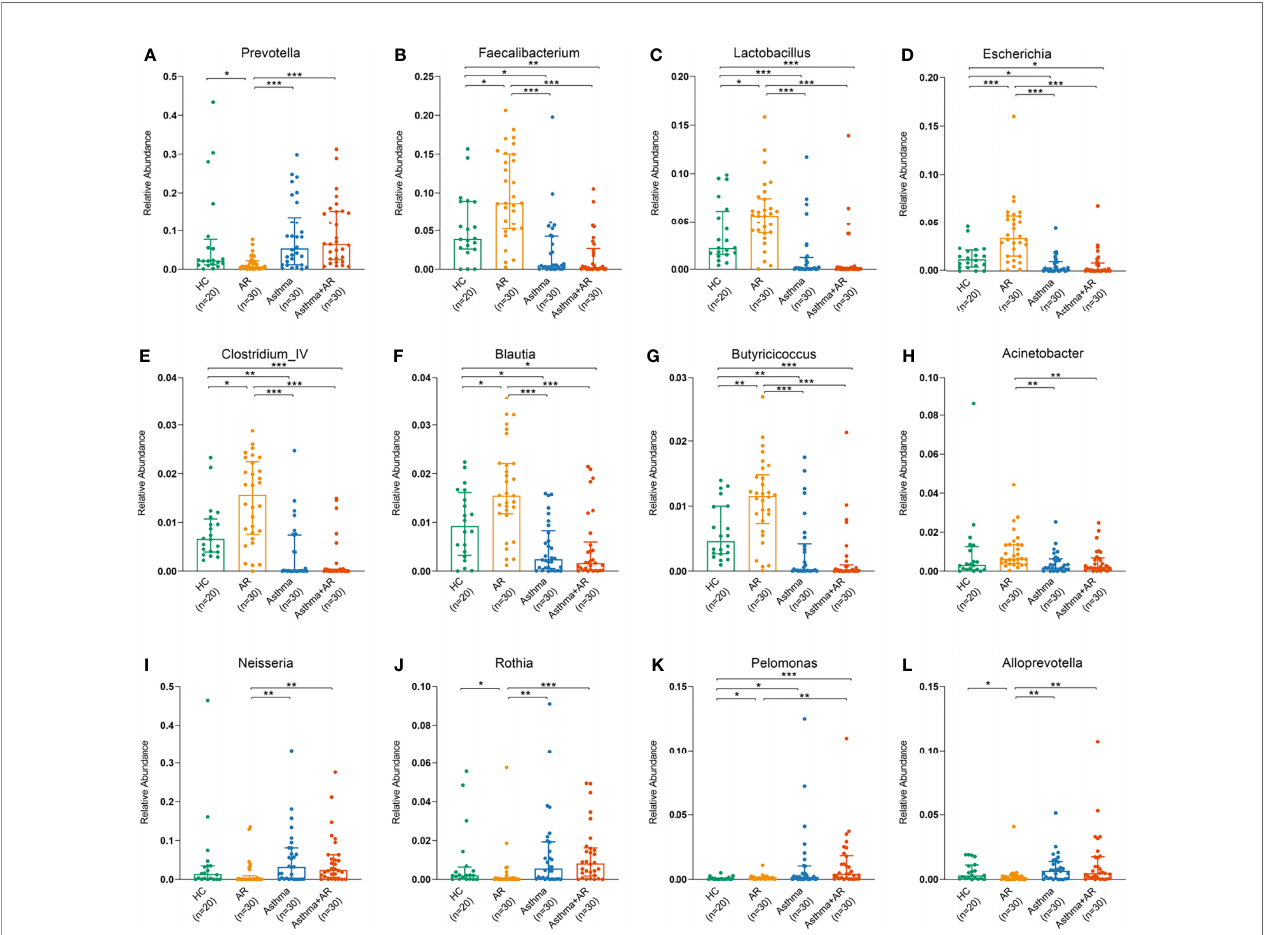
FIGURE 3 | Relative abundance of dominant bacterial genera among AR, asthma, combined asthma+AR and healthy controls. (A) Prevotella , (B) Faecalibacterium , (C) Lactobacillus , (D) Escherichia , (E) Clostridium_IV , (F) Blautia , (G) Butyricicoccus , (H) Acinetobacter , (I) Neisseria , (J) Rothia , (K) Pelomonas, and (L) Alloprevotella. Statistical signi fi cance was tested by Kruskal-Wallis test with Benjamini-Hochberg procedure. P < 0.05 was considered as statistically signi fi cant, * P < 0.05, ** P < 0.01, *** P <